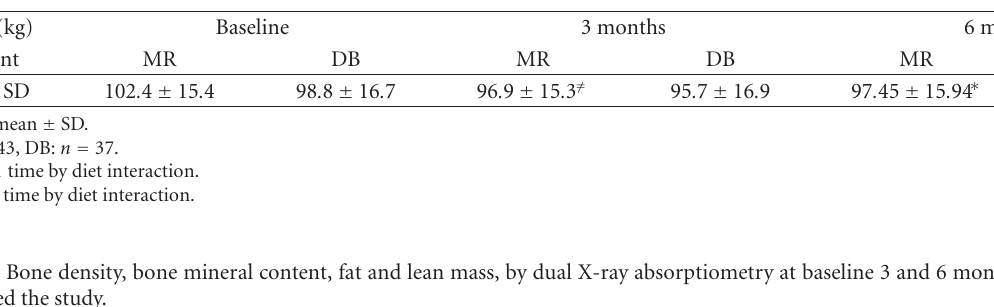
Table 3: Subjects who completed 6 months.